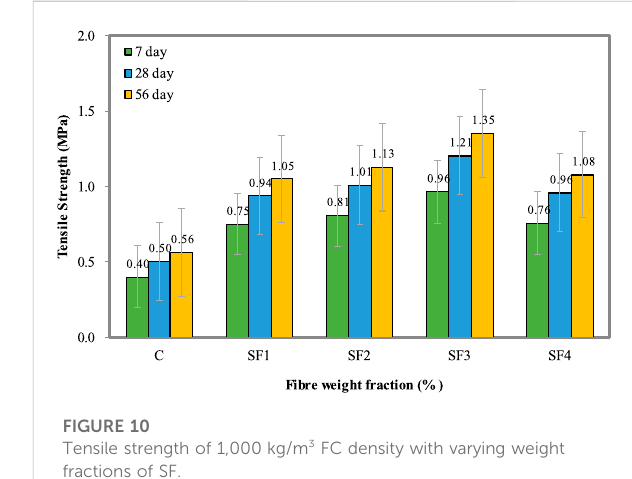
FIGURE 7 Flexural strength of 1,000 kg/m 3 FC density with varying weight fractions of SF.